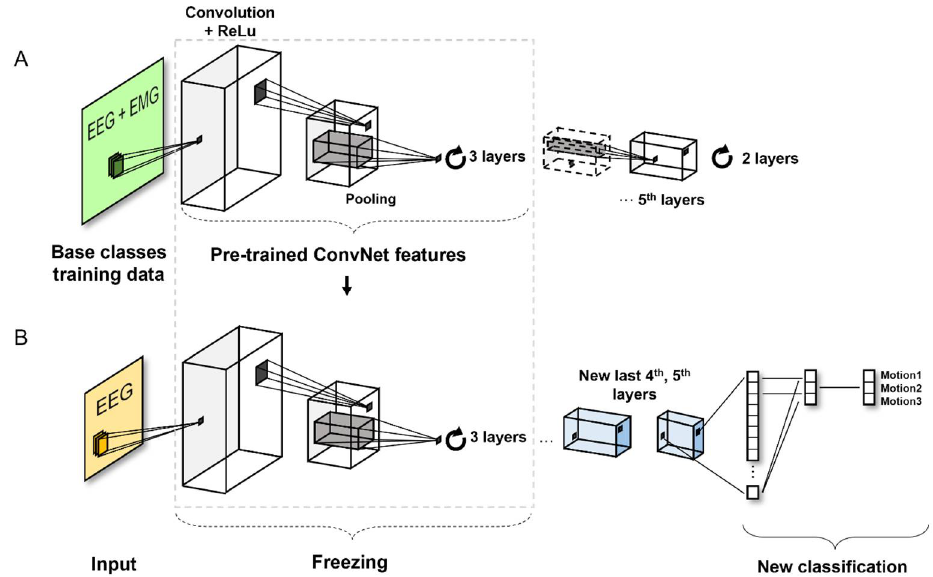
Figure 7. Architecture of present model showing ( A ) training model for motion classification based on pretrained CNN algorithm and ( B ) TL process based on that model. on pretrained CNN algorithm and ( B ) TL process based on that